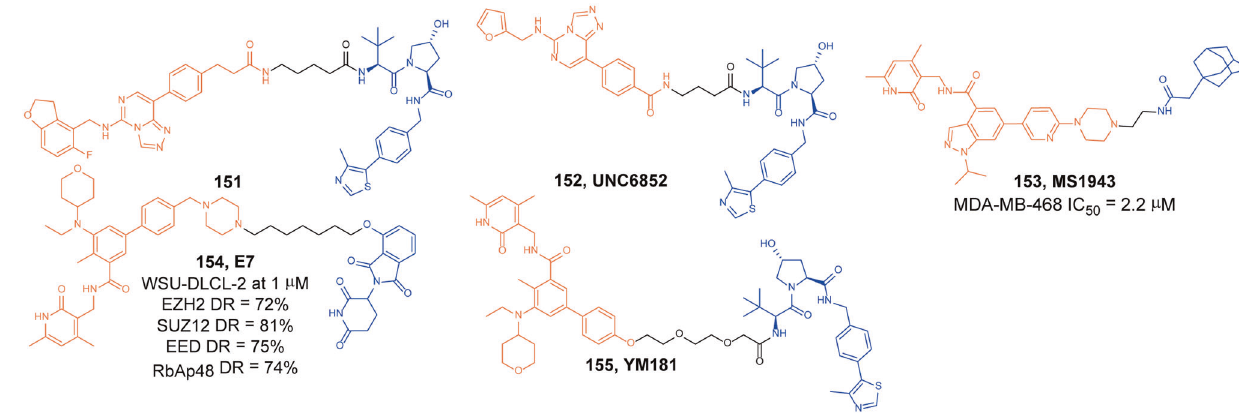
Fig. 37 The representative PROTACs targeting PRC2 (EZH2, EED)